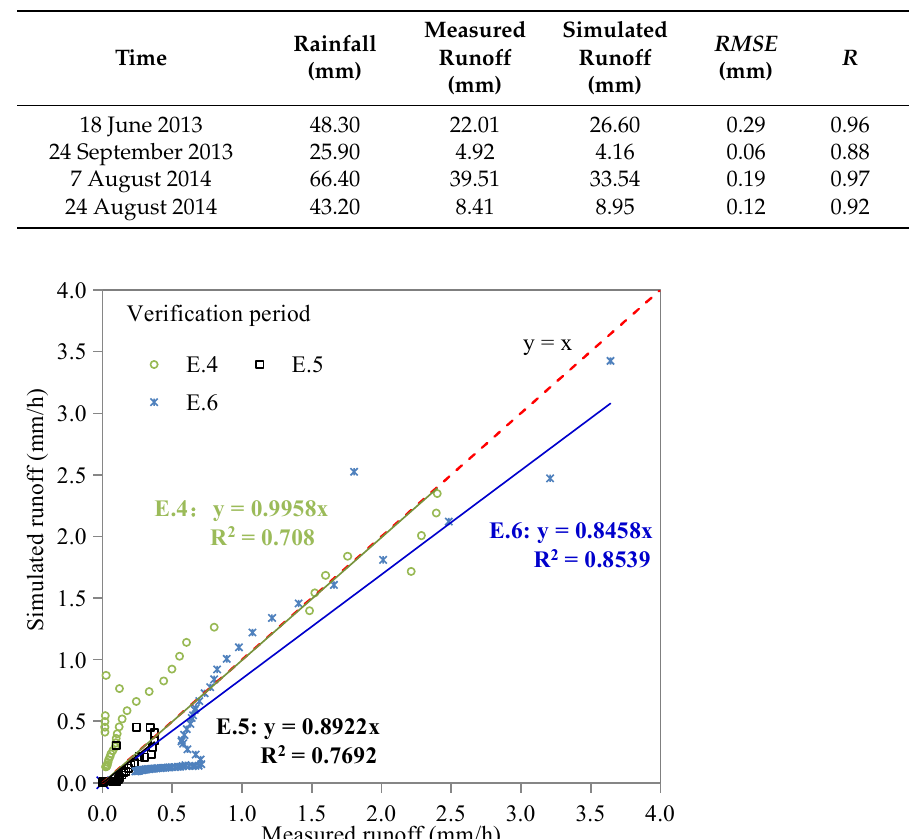
Table 7. Statistical indexes for the paddy field runoff model (validation period, ∆T = 1 h).